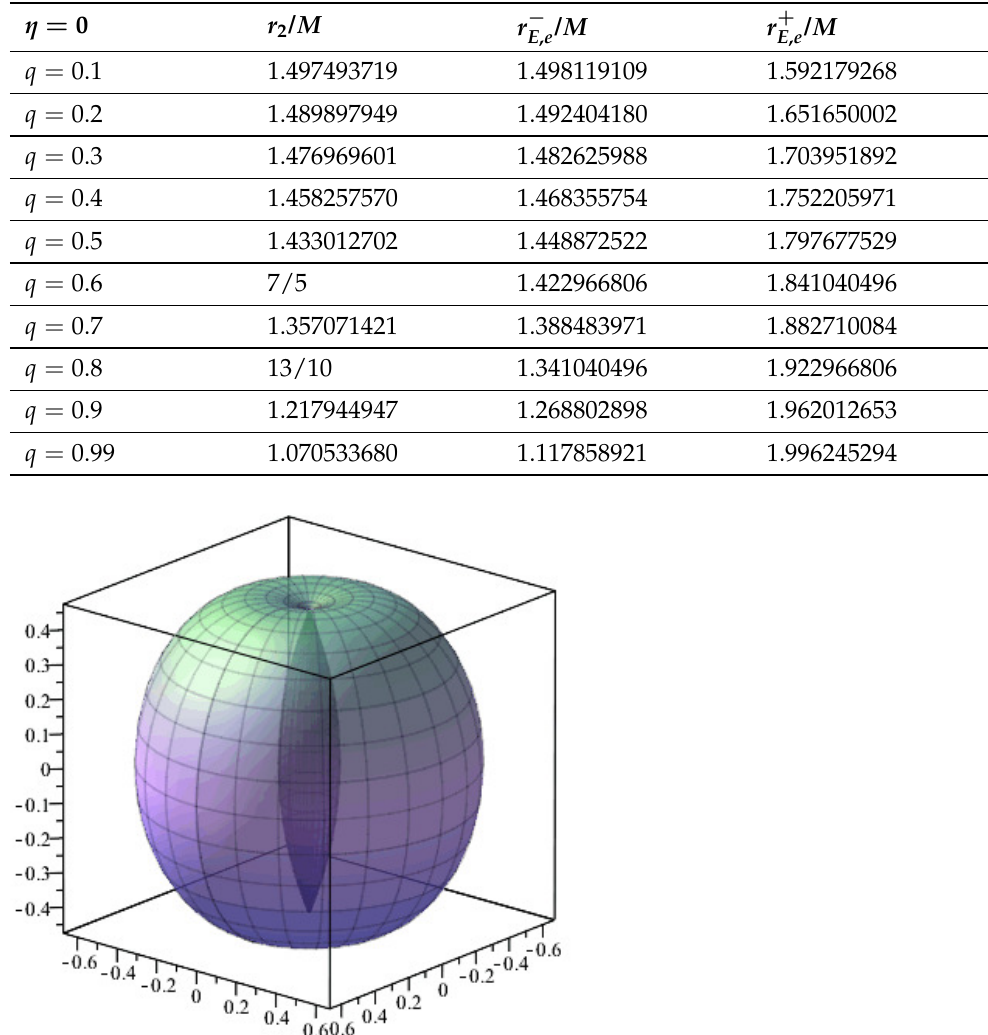
Figure 1. Plot of of the ergoregion for q = 0.5 and M = 1. Cusp singularities emerge at the top and bottom of the inner surface of the